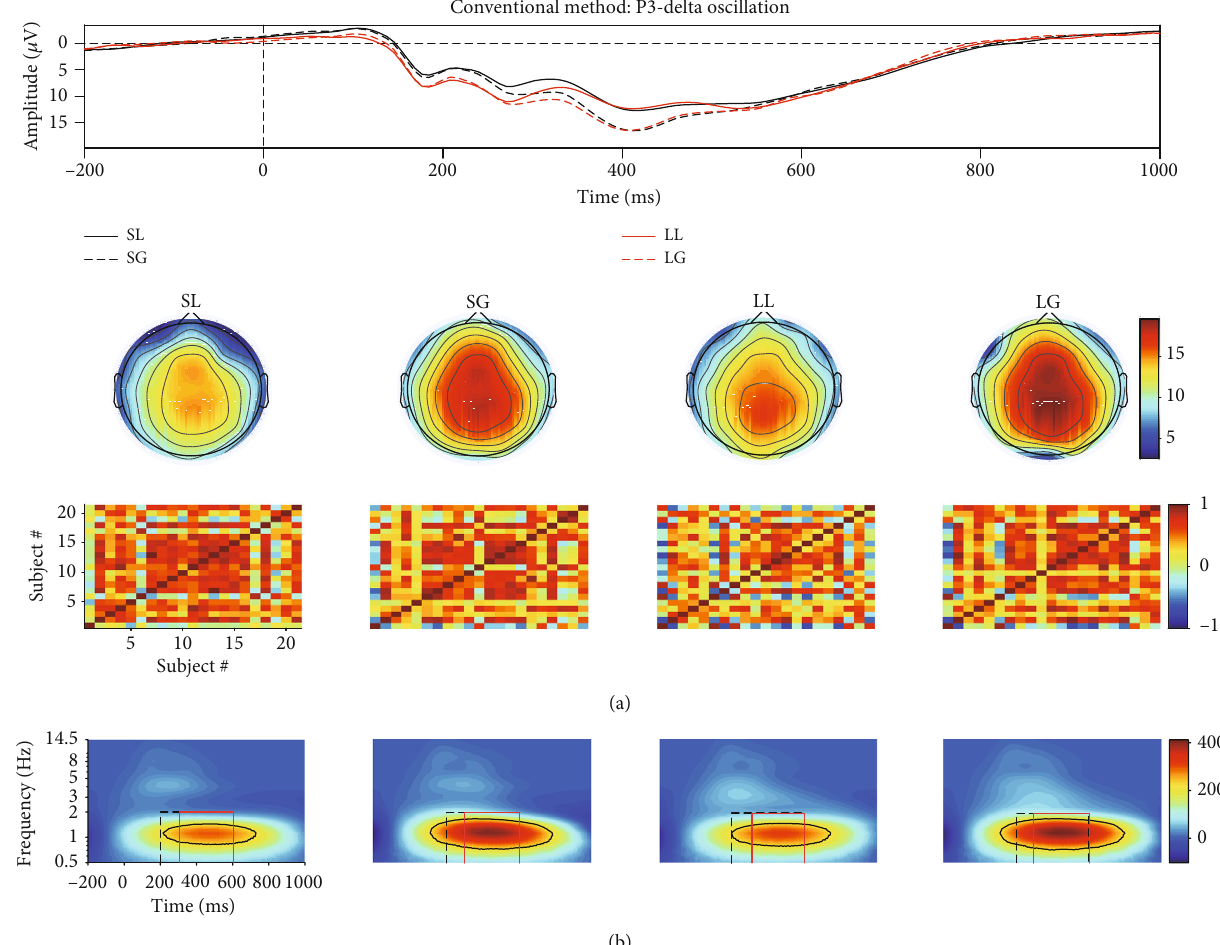
Figure 7: (a) The grand averaged waveform (at Fz, FCz, Cz, CPz, and Pz electrodes), topography (time window: 300-600 ms), and similarity of topographies across participants of each condition for the fi ltered real signal. (b) The associated grand averaged time-frequency representation (TFR) of every condition obtained by the conventional TFA. The region of evoked ERO of each condition was determined by the edge detection algorithm and the conventional rectangle method separately (for the black dotted rectangle, the time window was set from 200 to 600 ms and frequency range was de fi ned from 0.5 to 2Hz, “ R7 ” ; the red solid rectangle: 300-600ms and 0.5-2 Hz, “ R8 ” )